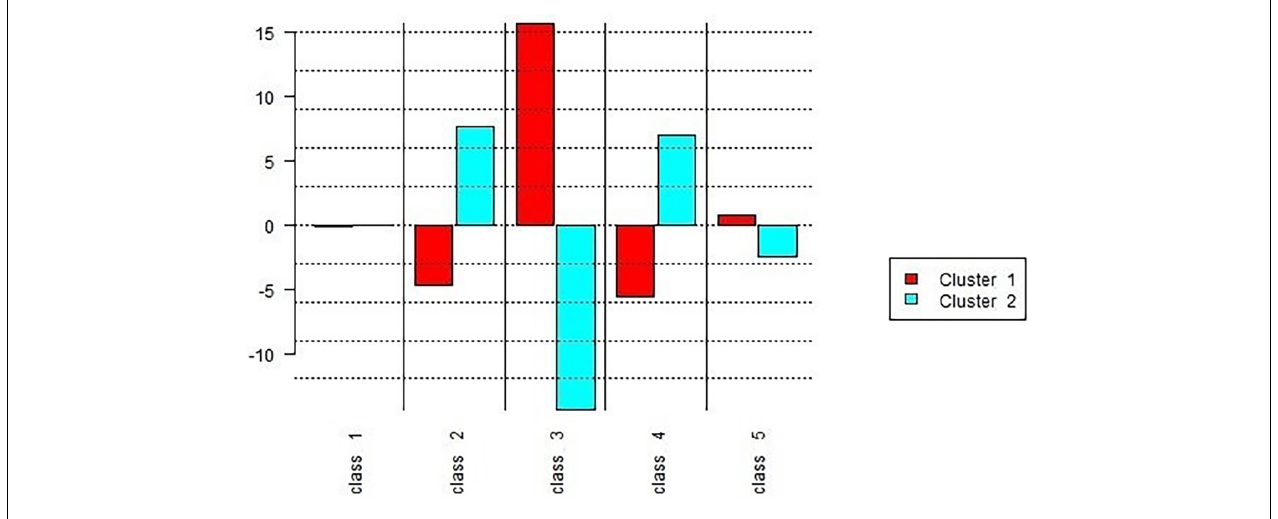
FIGURE 2 | Chi-square between clusters and classes of